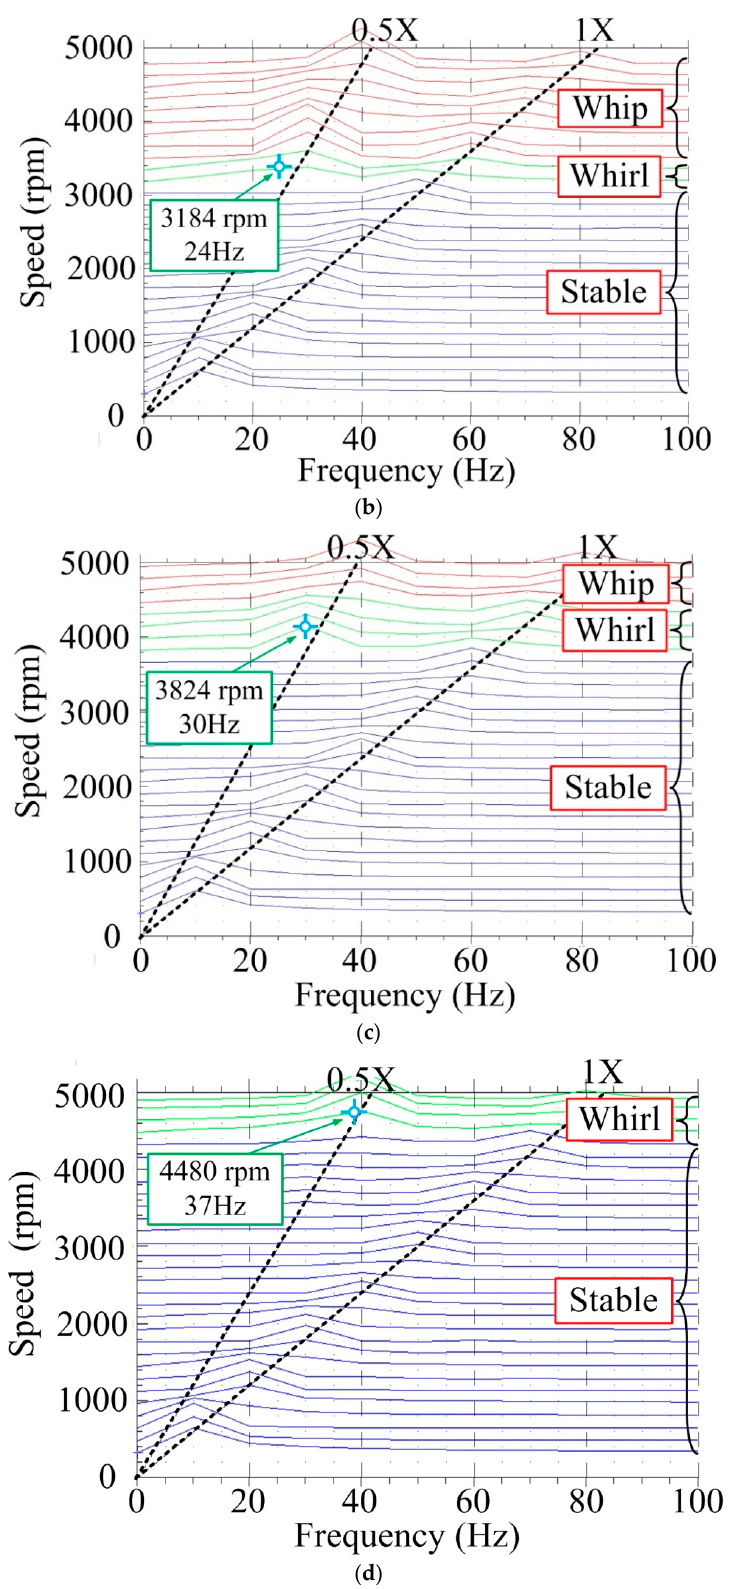
Figure 7. Full spectrum cascade plots of oil bearing for different magnetic field. ( a ) Cascade plots with 3 magnets; ( b ) Cascade plots with 5 magnets; ( c ) Cascade plots with 7 magnets; ( d ) Cascade plots with 8